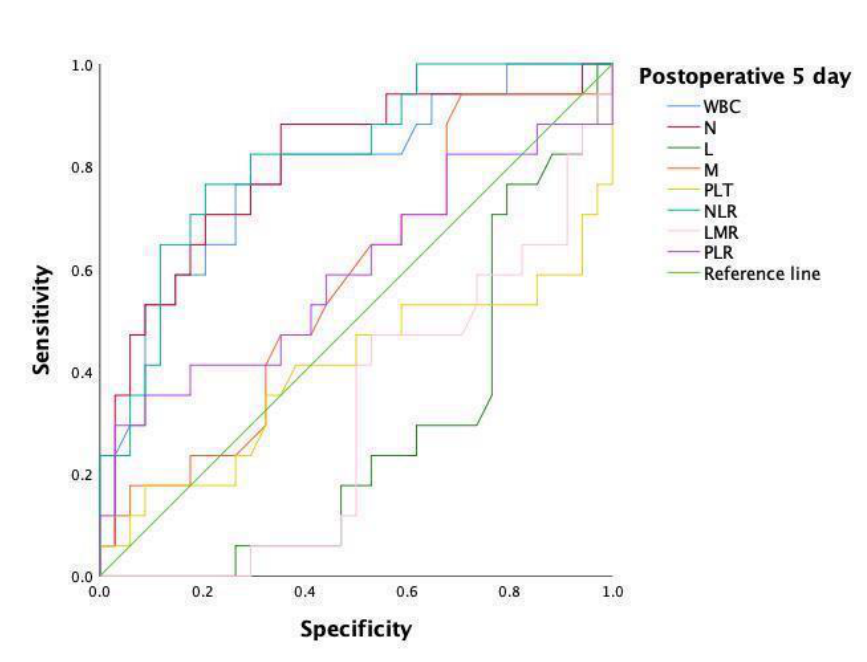
Figure 4. ROC curve after PSM analysis on day 5 after surgery.